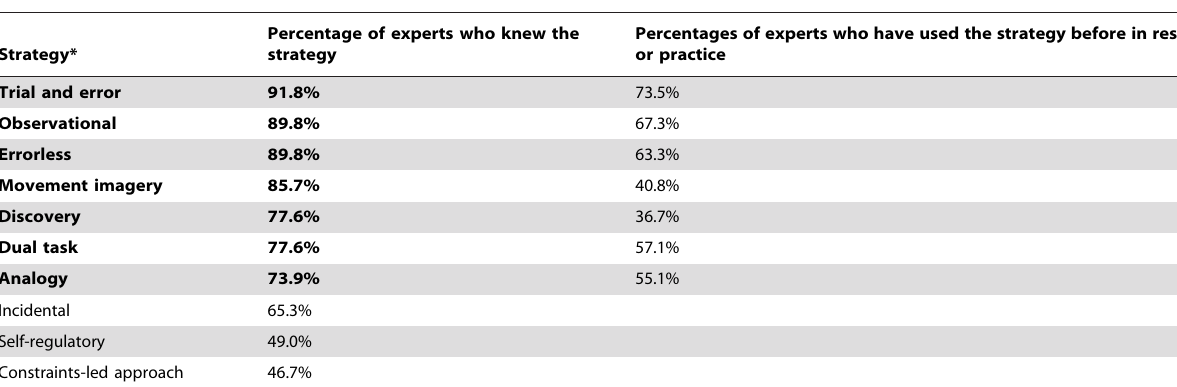
Table 5. Percentage of experts who knew/used the provided